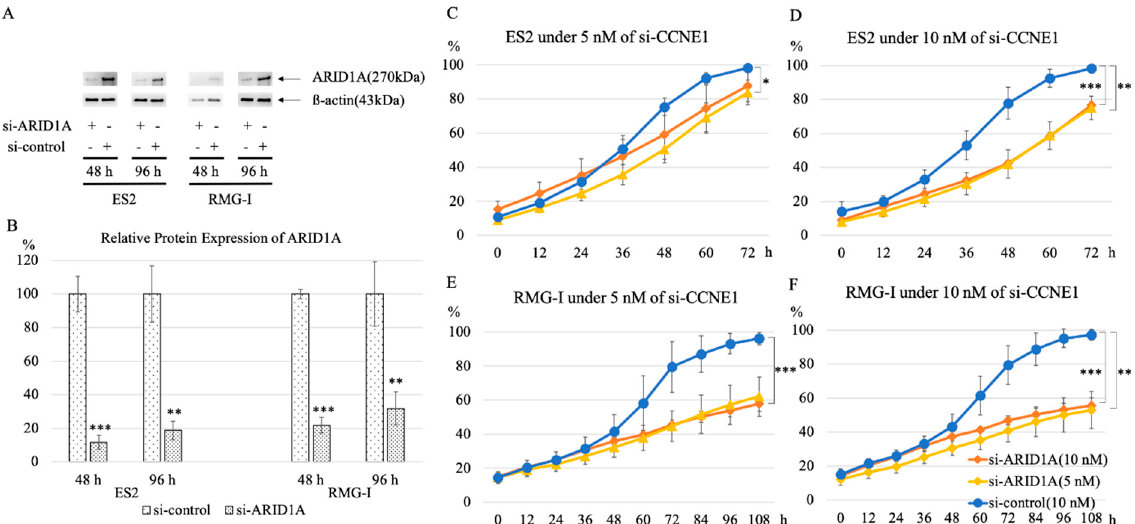
Figure 6. Knockdown of CCNE1 inhibits cell proliferation of ARID1A interfered cell lines. The protein expression levels of ARID1A , decreased by 10 nM more in the ES2 and RMG-I cell lines than 5 nM interference ( n = 3 per group) in macroscopically ( A ) and statistically ( B ). Interference of ARID1A in ES2 induced susceptibility to CCNE1 interference by 5 nM (C) or 10 nM (D), irrespective of si-ARID1A concentration (5 nM or 10 nM) ( n = 5 per group), and also in RMG-I showed the same result by 5 nM (E) or 10 nM (F). *** p < 0.001 and ** p < 0.01 vs. control.